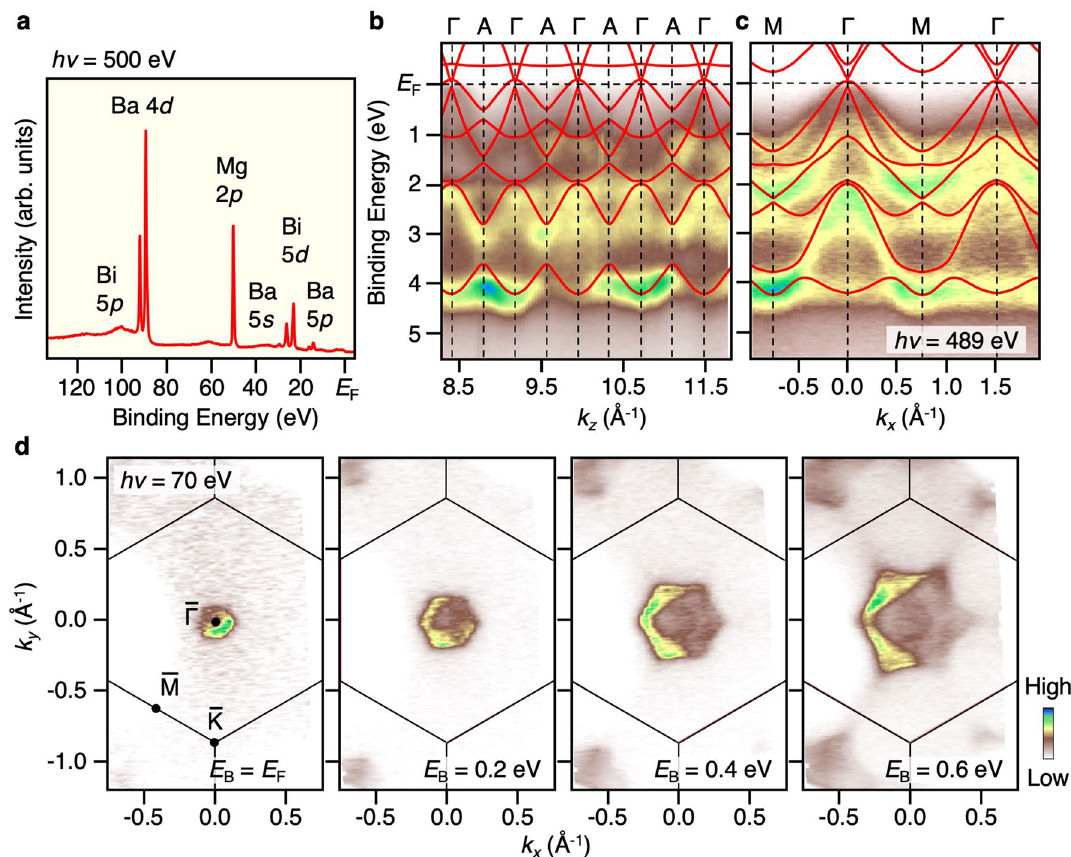
Figure 2. ( a ) Energy distribution curve of BaMg 2 Bi 2 in a wide binding-energy ( E B ) range measured at hν = 500 eV. ( b ) ARPES intensity of BaMg 2 Bi 2 measured at T = 40 K along the ΓA cut by varying hν from 250 to 522 eV, together with the calculated band structure (red curve). The inner potential was estimated to be V 0 = 15.0 eV from the periodicity of out-of-plane band dispersion. ( c ) ARPES intensity along the Ŵ M cut measured at hν = 489 eV. Calculated band structure along the ΓM cut is also overlaid. ( d ) Plots of ARPES intensity as a function of two-dimensional wave vector ( k x and k y ) at representative E B slices ( E B = 0, 0.2, 0.4, and 0.6 eV) measured at hν = 70 eV for BaMg 2 Bi 2